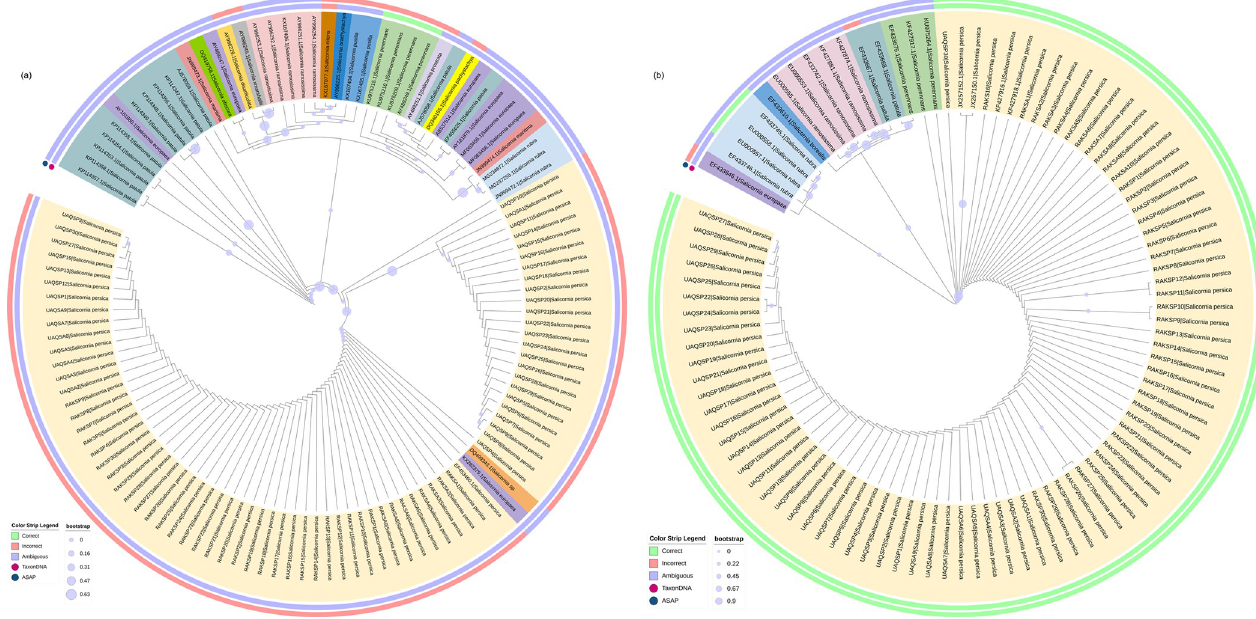
Fig 2. Molecular identification of Salicornia sp. using the maximum likelihood approach, and their annotation using OTU picking methods TaxonDNA’s Species identifier and ASAP. ML trees were constructed with bootstrap support (of 1000) and with discrete gamma distribution (a) ML tree of ITS2 sequences obtained using Tamura 3-parameter model, (b) ML tree of ETS sequences obtained using Kimura 2-parameter model.